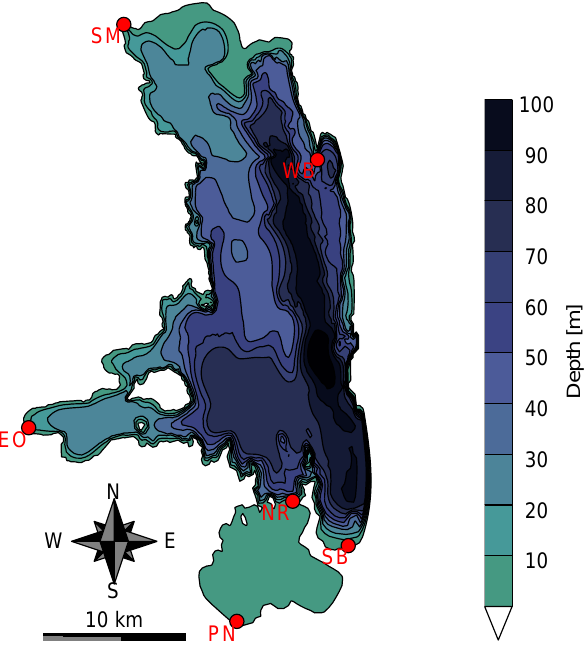
Figure 1. Flathead Lake: bathymetry map and location of pressure and water level measurement sites (red circles), referred to in the